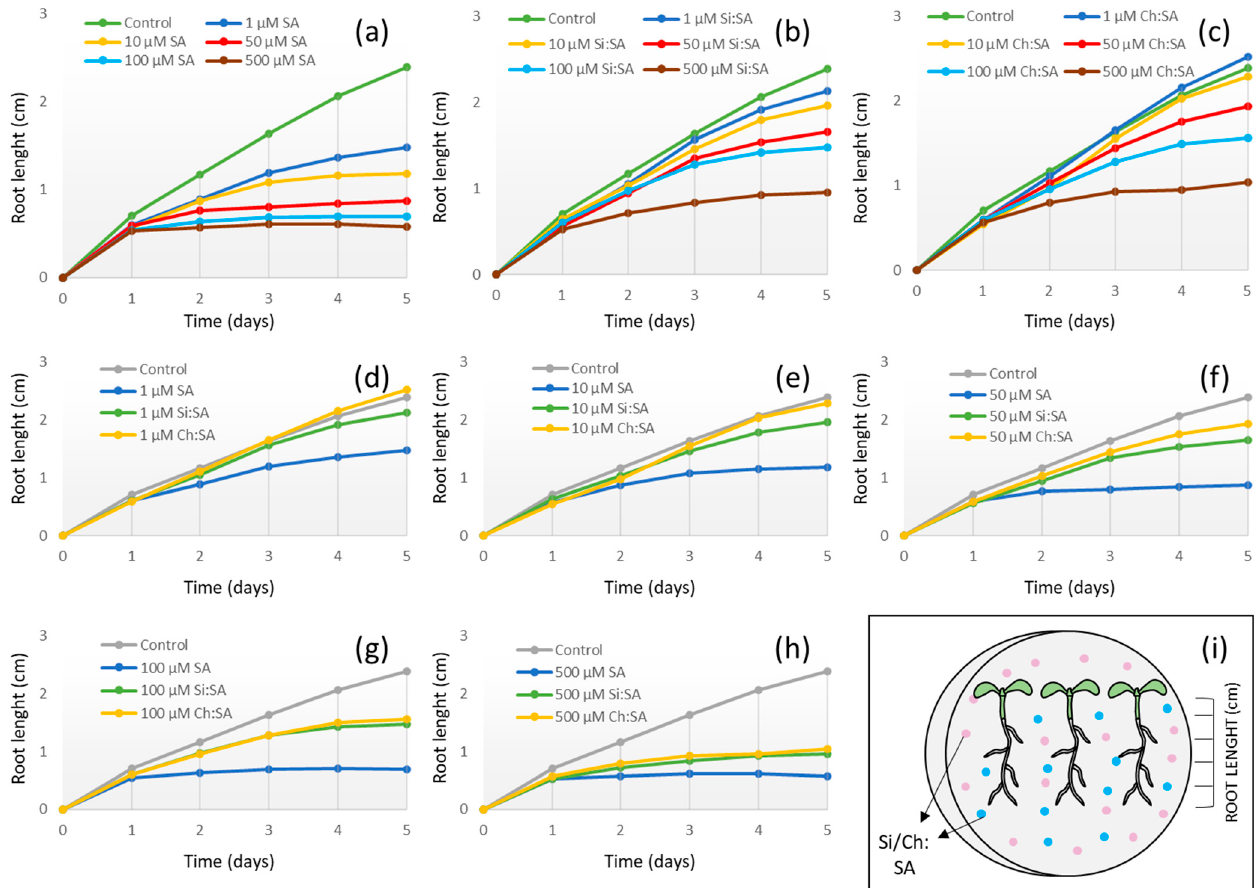
Figure 3. Effect of free SA, Si:SA and Ch:SA on root growth in Col-0 Arabidopsis plants. Five-day- old plants were transferred to media containing the different SA treatments and root length was measured daily (Scheme ( i )). Graphs ( a – c ) compare root length among the doses at each treatment, and graphs ( d – h ) compare root length among the treatments at each dose.